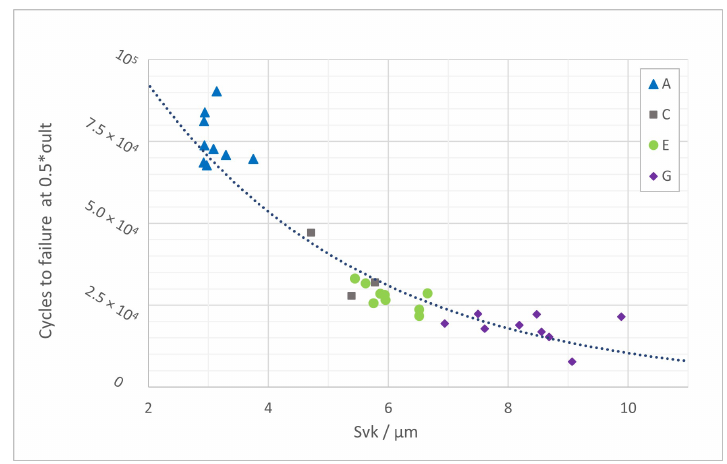
Figure 10. Exponential fit Svk vs. cycles to failure at 0.5 σ ult